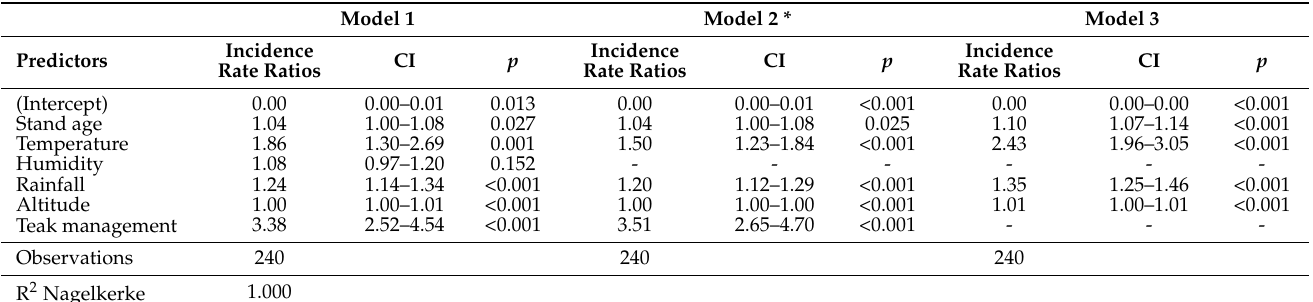
Table 3. Generalized linear models relating abundance of ambrosia beetles to stand age, altitude, temperature, rainfall, humidity, and teak management.